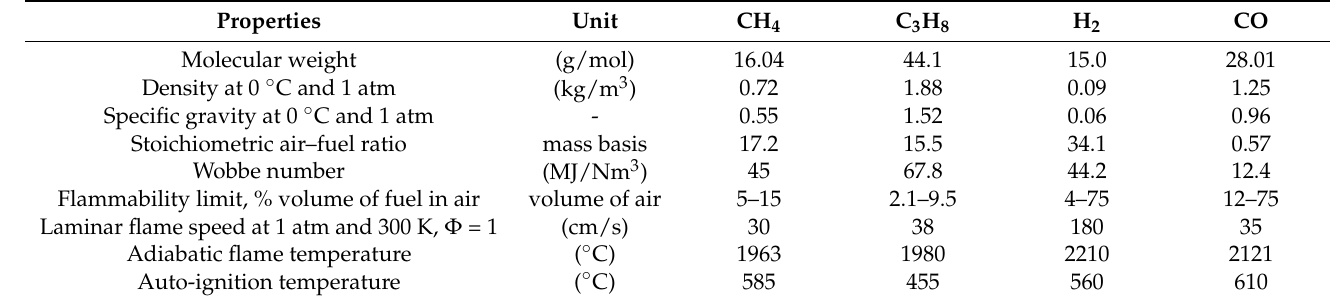
Table 1. Physiochemical properties of the studied gaseous species